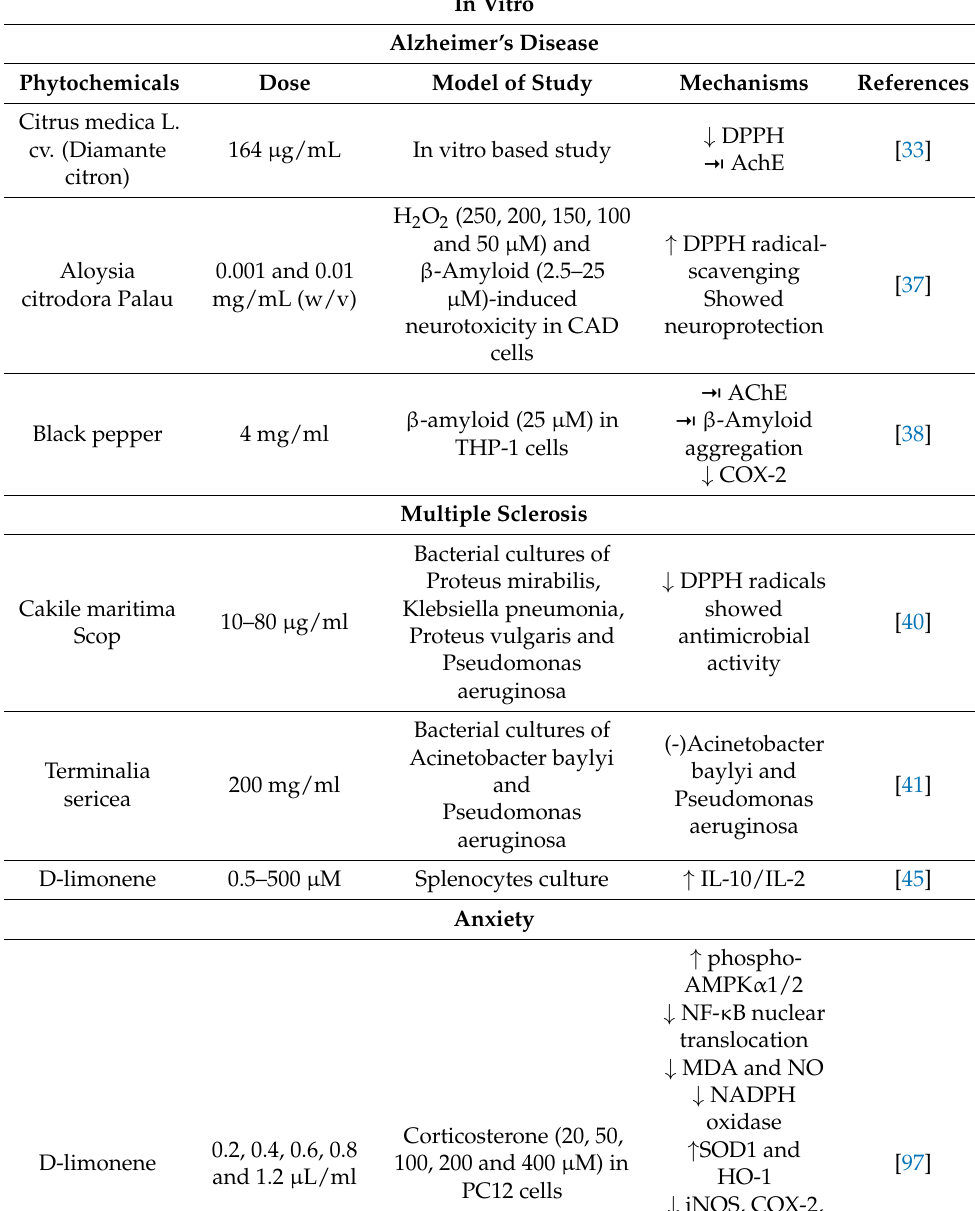
Table 2. The in vitro studies demonstrating the neuroprotective actions and mechanisms of limonene.